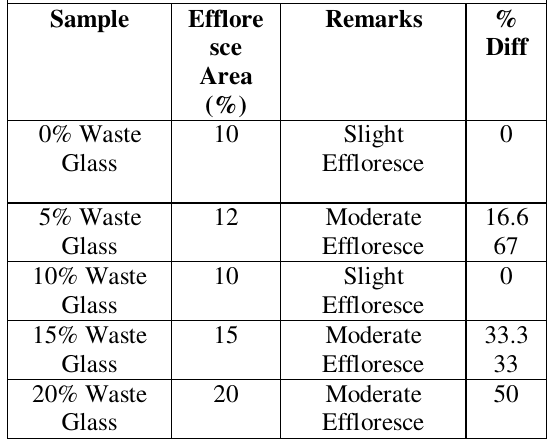
Table 3: Efflorescence results with percent